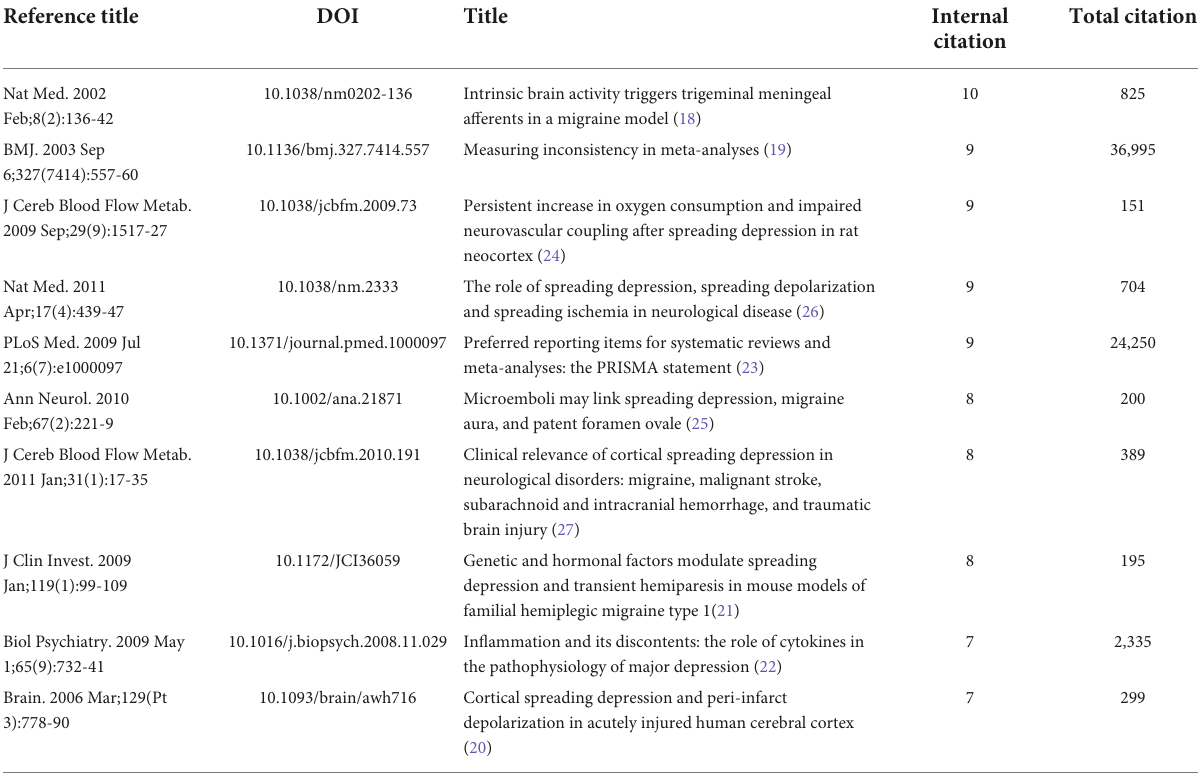
TABLE 3 Top 10 review publications of major depressive disorder (MDD) and radiology based on internal